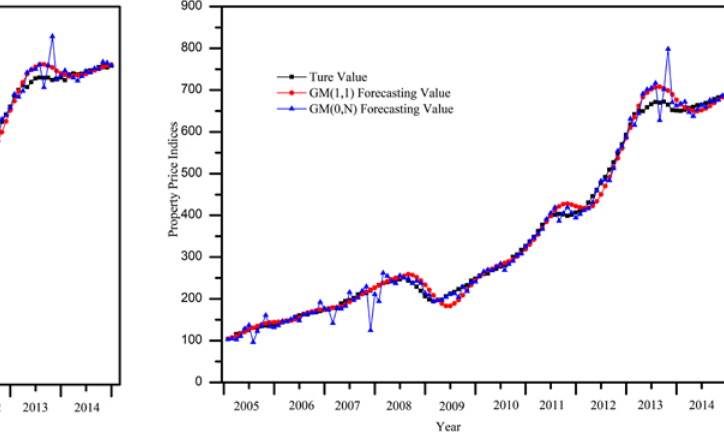
Fig. 6. Fitting lines of forecast values and Fig. 4. Fitting lines of forecast values